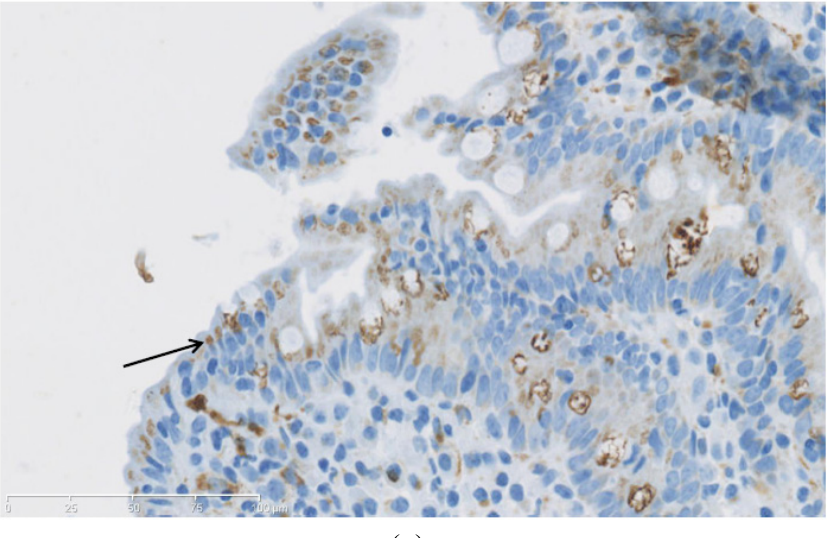
Figure 1. Peanut agglutinin (PNA) staining. ( a ) Patient B3 (CD, untreated), score 1; ( b ) Patient A7 (CD+T1D, untreated), score 2; ( c ) Patient A7 (CD + T1D, on GFD), score 3; ( d ) Patient C2 (non-CD), score 3. Thin arrows mark staining of cytoplasm of epithelial cells. Thick arrows mark staining of glycocalyx. Arrowheads mark staining in goblet cells.